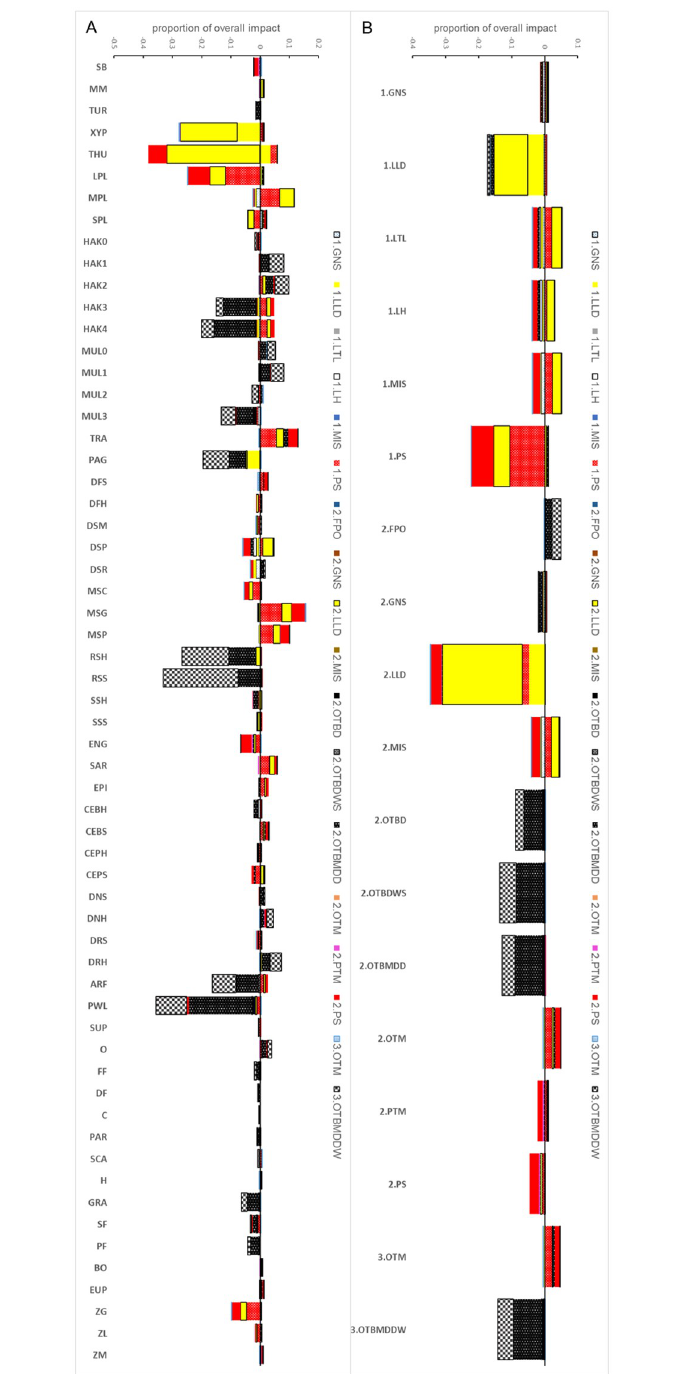
Fig 8. Results of the MTI analysis for fleets of the SoS ecosystem model. (A) overall impact across biological functional groups. (B) conflicts (negative values of MTI) and benefits (positive values of MTI) among fleet segments.